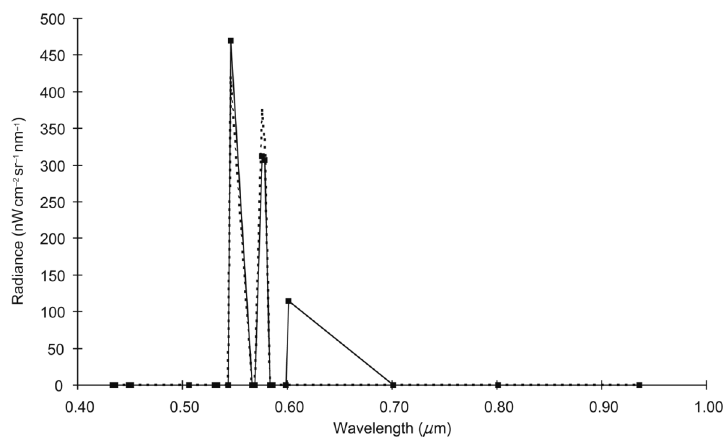
Fig. 3. Spectra of two city lights at two different pixels extracted from the VIRS 200 image, after processing for dark-signal subtraction, flat-field calibration and transformation to radiance units. The square symbols indi- cate the wavelength position of the VIRS 200 channel.